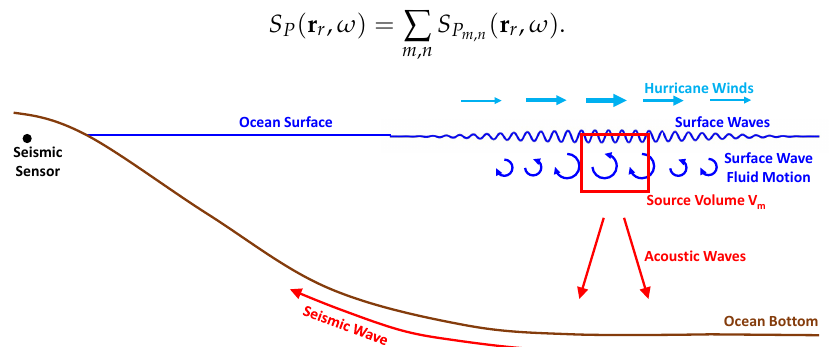
Figure 3. Geometry of the hurricane wave field and ocean waveguide (not to scale). In our model